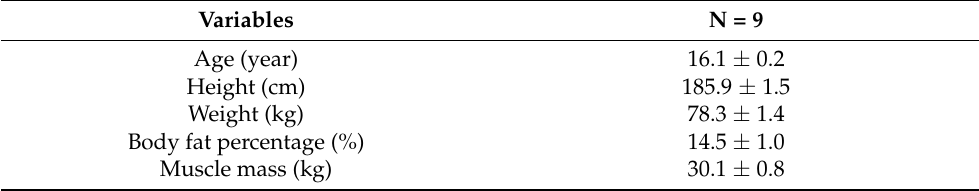
Table 1. Anthropometric data of